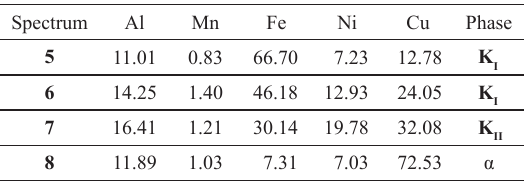
Table 2. Local EDX point analysis of the alloy components (wt. %) detailed in Figure 3. Spectrum